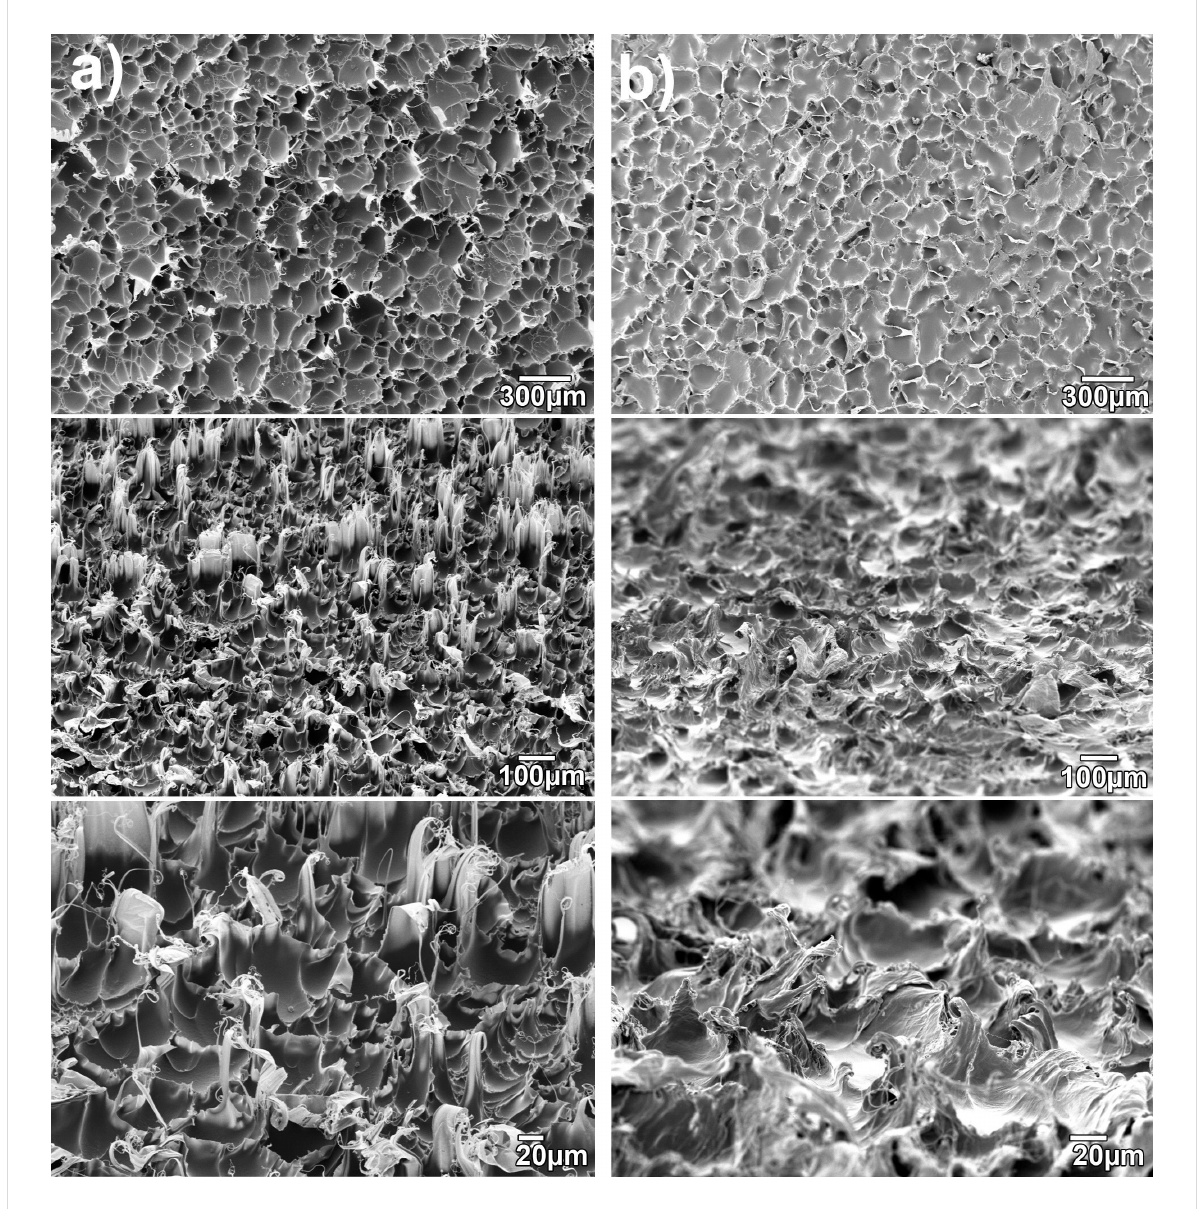
Figure 6: Comparison between nanofur produced by classical hot embossing and R2R nanofur. Even though morphological differences are obvious, the two samples do not differ in function, that is, contact angle. Column (a): Nanofur produced by classical hot embossing. The hairs stand out sepa- rately and are relatively straight with a high aspect ratio. Column (b): Nanofur produced by a roll-to-roll process. The topmost pictures are a top view, the others have been taken at a tilt angle of 60°. The structures consist of ridges that culminate in hair-like structures. These ridges can be slightly slanted against the direction in which the polymer traveled through the